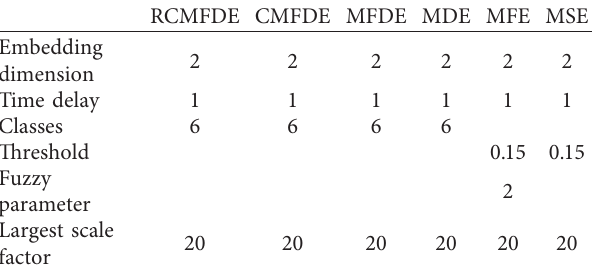
Figure 12: Outputs of testing samples. Table 5: Parameters of different methods.